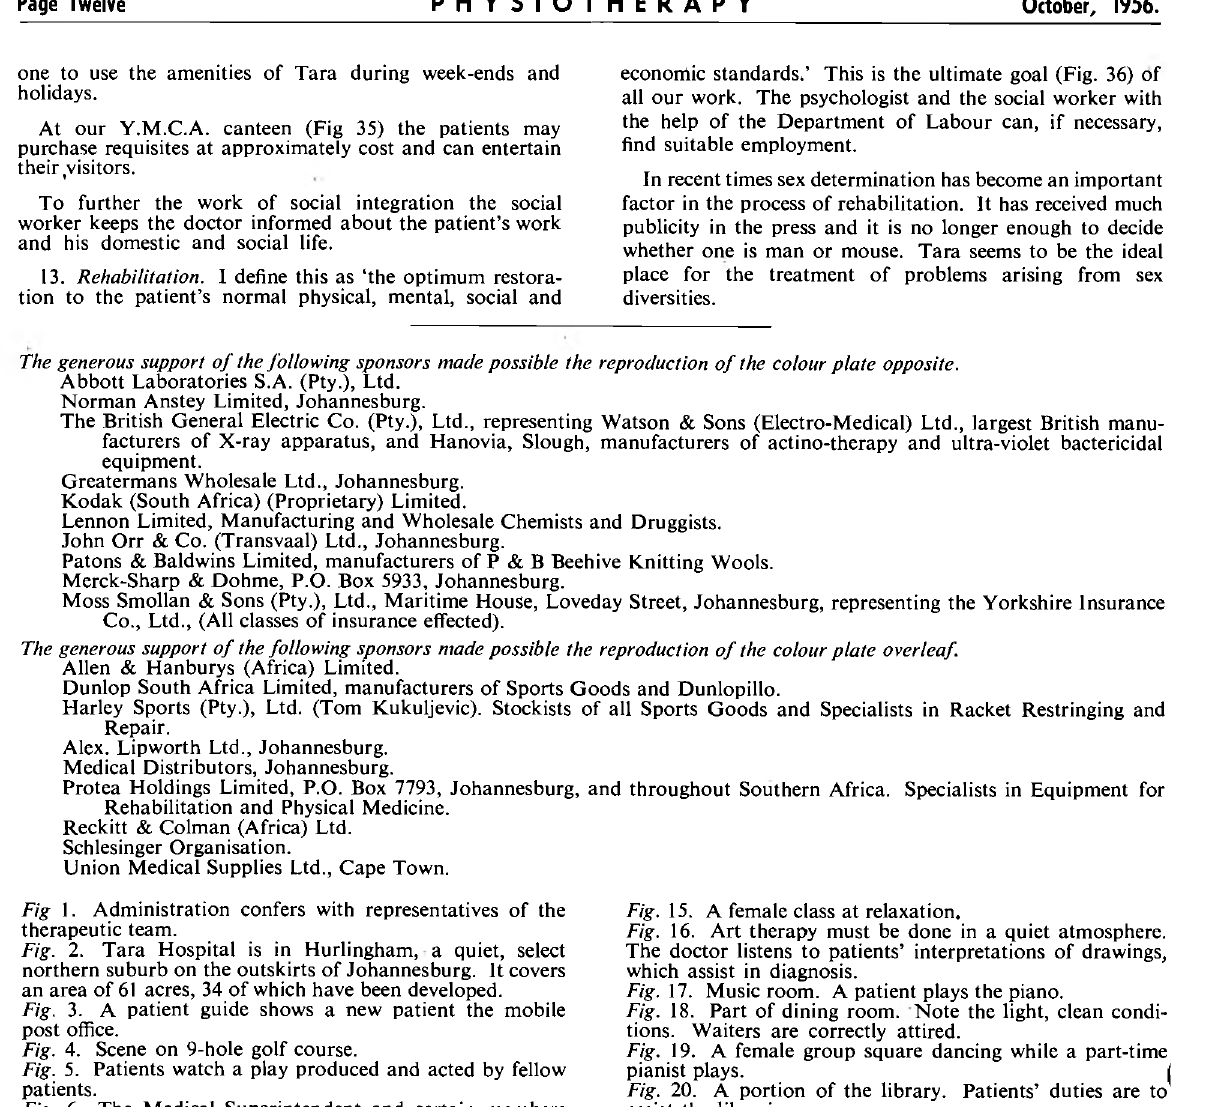
pianist plays. | Fig. 20. A portion of the library. Patients’ duties are to assist the librarian. Fig. 21. The snooker room is very socializing. Mainly males. Concentration is essential. Fig. 22. Telephone duties are taken on by females. Messages are written on the board. This restores confidence. Fig. 23. Part of equipment room. Note the completeness; also the cups and trophies. Fig. 24. Cricket (for the younger males) assists con­ centration. Fig. 25. Hockey. Our patients are divided into 2 main sides—yellow (The Tigers) and red (The Lions) —to stimulate the competitive spirit. Note the mixed group. Fig. 26. Softball is a good outlet for suppressions, socializing for team and spectators. Mixed group, with a wide range of ages. Fig. 27. Concentration is essential in archery. Mixed group. Less active, e.g. wheel-chair patients. Fig. 28. Croquet is socializing for the less active (mainly females). Fig. 29. Tennis on one of the 4 courts for a physically fit mixed group. Fig. 30. Tenniquoits (mixed group) maintains